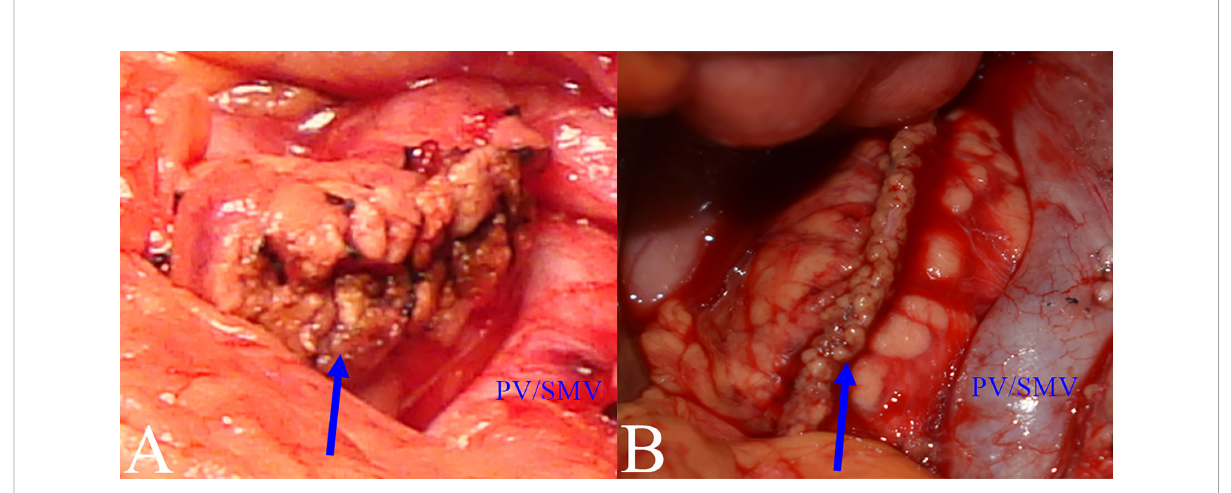
FIGURE 2 Closure methods for pancreatic remnants. (A) Hand-sewn closure: pancreatic remnant after closure (blue arrow). (B) Stapler closure: pancreatic remnant after closure (blue